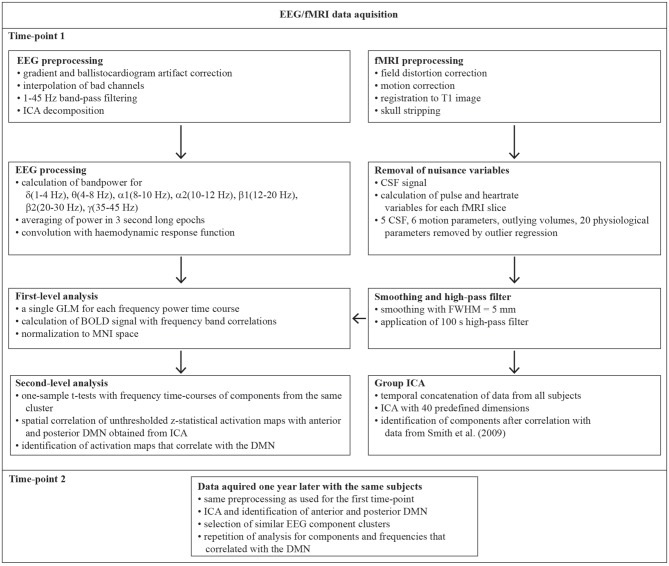
Schematic overview of the functional magnetic resonance imaging-electroencephalographic (fMRI-EEG) processing pipeline. The two time-points were 1 year apart. ICA, Independent Component Analysis; CSF Cerebrospinal fluid; FWHM, Full Width Half Maximum; GLM, General Linear Model; MNI, Montreal Neurological Institute; BOLD, Blood Oxygenation Dependent Signal; DMN, default mode network.